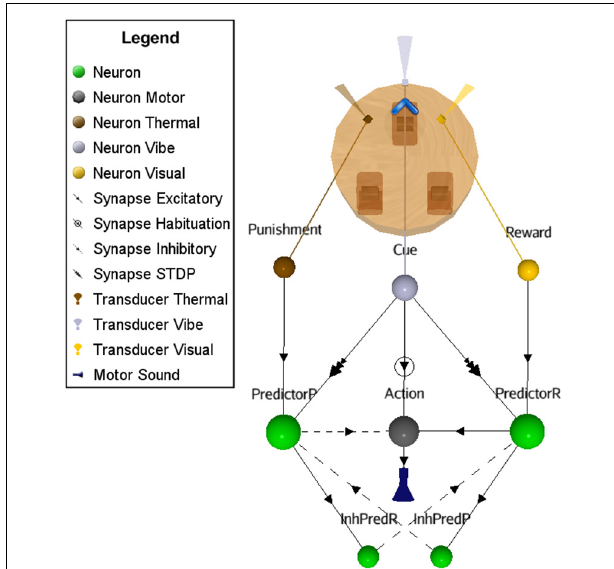
FIGURE 6 | ASNN and associated external robot structure built to exhibits opposing behaviors of emitting or not a sound. The proposed ASNN includes the previous one ( Figure 4 ), sharing some elements of the minimal components requirement. The Punishment sensory neuron (heat) is added as a negative reinforcer and renamed Reward neuron as in the positive reinforcer (light-visual). We individualized the Predictor neurons in respect of the attached reinforcer. Each behavior mutually inhibits the opposite